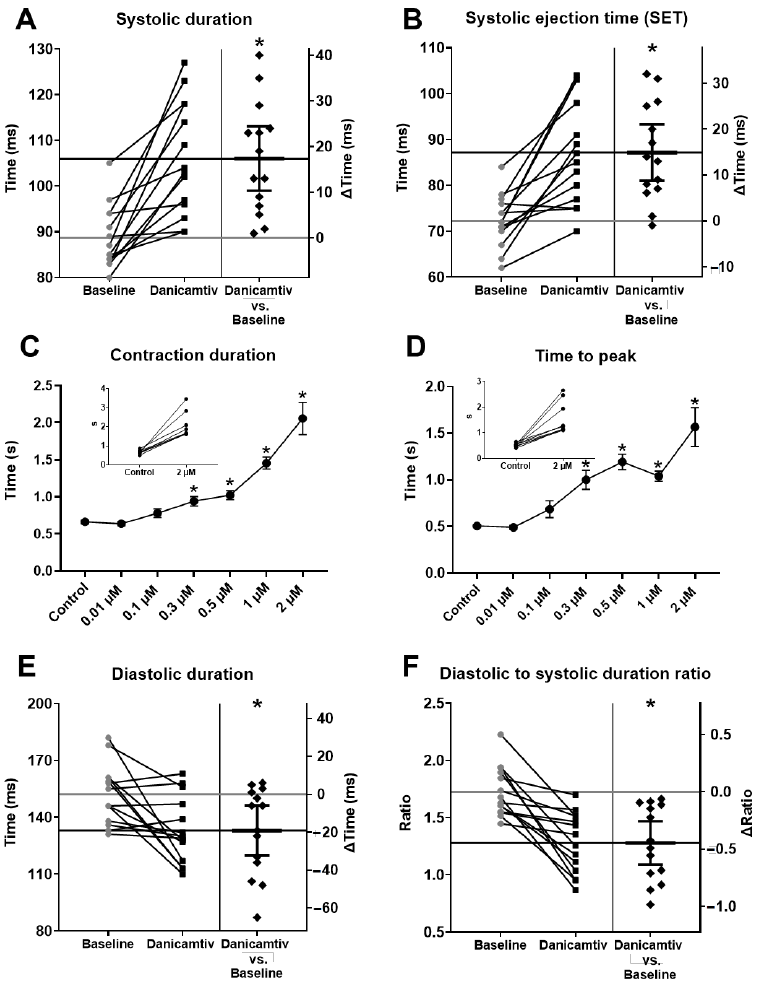
Figure 3. Danicamtiv increased the durations of systoles and decreased the durations of diastoles. Danicamtiv prolonged both systolic durations and systolic ejection time ( A , B ). When danicamtiv was added to the tissue chamber in different concentrations (0.01 µM to 2 µM), a progressive in- crease in contraction duration and time to peak interval could be observed ( C , D ). The results of individual experiments are shown in the insets. The symbols represent the mean and standard error of the mean. Significant differences from the baseline values upon application of danicamtiv are indicated by asterisks. Danicamtiv decreased diastolic duration ( E ) with a consequent decline in the ratio of diastolic to systolic durations ( F ). (The construction of panels is identical with the corre- sponding ones in Figure 1). * = p < 0.05.